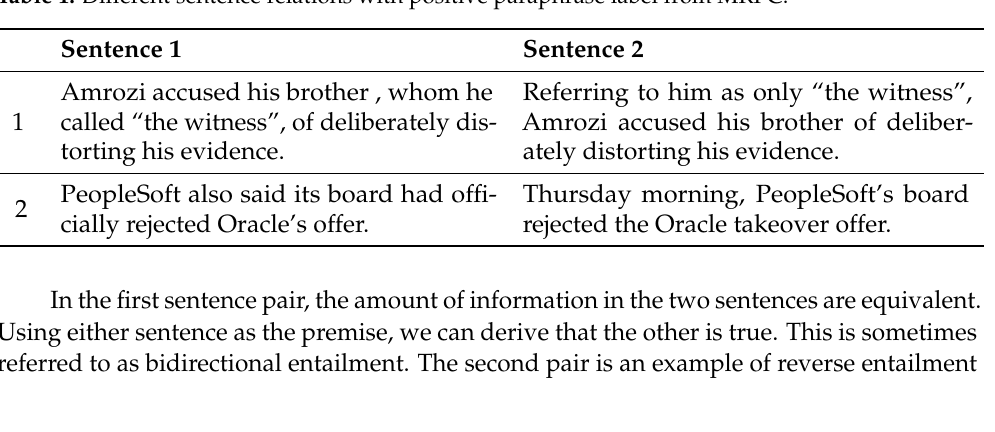
Table 1. Different sentence relations with positive paraphrase label from